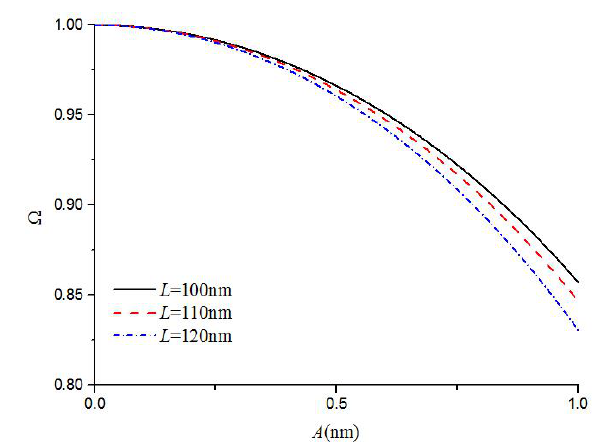
Fig. 1. The effect of length to the amplitude-frequency response